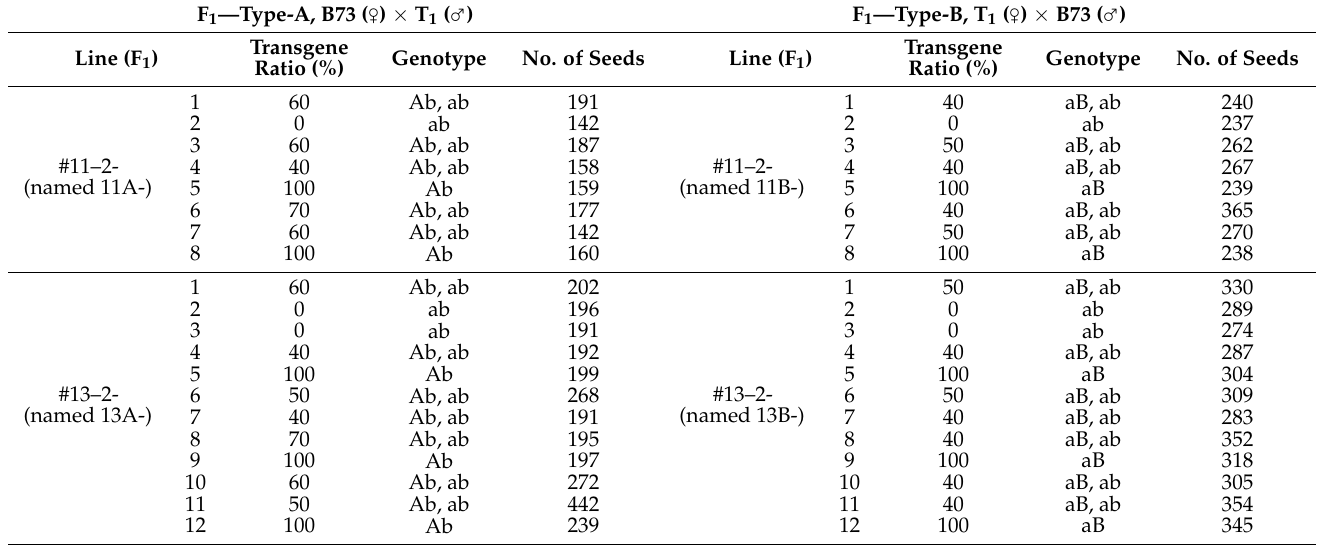
Table 1. Summary of the genotypes of F 1 hybrid transgenic maize lines #11–2 and